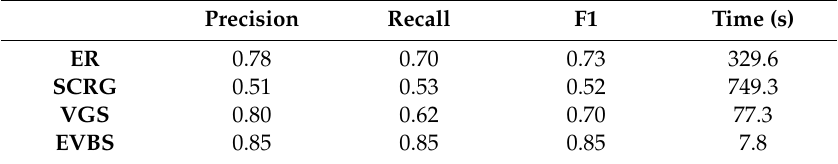
Figure 12. Mobile laser scanner data. ( a ) Mobile laser scanner point cloud obtained by the MATIS Laboratory, and ( b ) ground truth data obtained by manual segmentation.